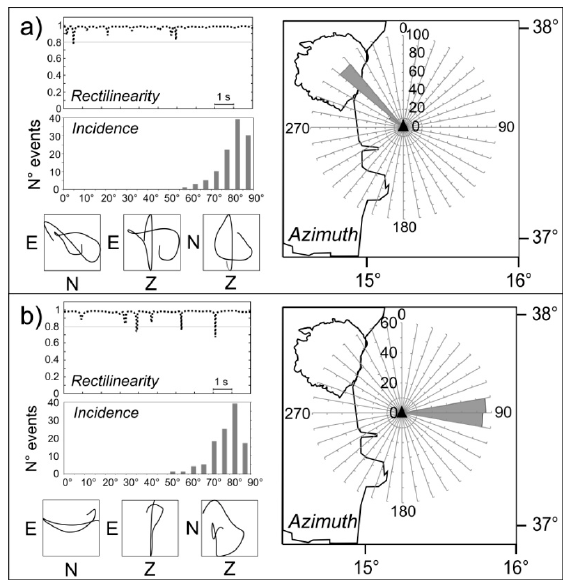
Figure 7. Polarization and particle motion computed on amplitude increases associated with: ( a ) volcanic tremor and ( b ) oceanographic noise. Examples of rectilinearity, incidence, and azimuth values computed on a 10-s-long window of 0.1–2 Hz-filtered signal; hodograms of particle motion were computed on a 4-s-long window. A total of 110 windows for both volcanic tremor and oceanographic noise were analysed. Polarization and particle motion show high values of rectilinearity (> 0.8) and high incidence angles (> 60°), typical converted phases from P-waves to S-waves (P-to-S) at the seafloor boundary in both signals. The azimuth values reported in the two rose diagram show that the volcanic tremor propagated from NW to SE, compatible with a wave front coming from Mt. Etna; oceanographic noise shows a constant E–W direction roughly perpendicular to the coast and consistent with the sea wave direction of propagation.